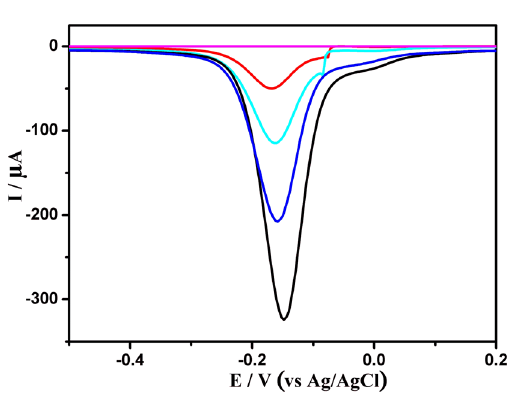
Figure 3. Schematic illustration of the fabrication process of the immunosensing interface.